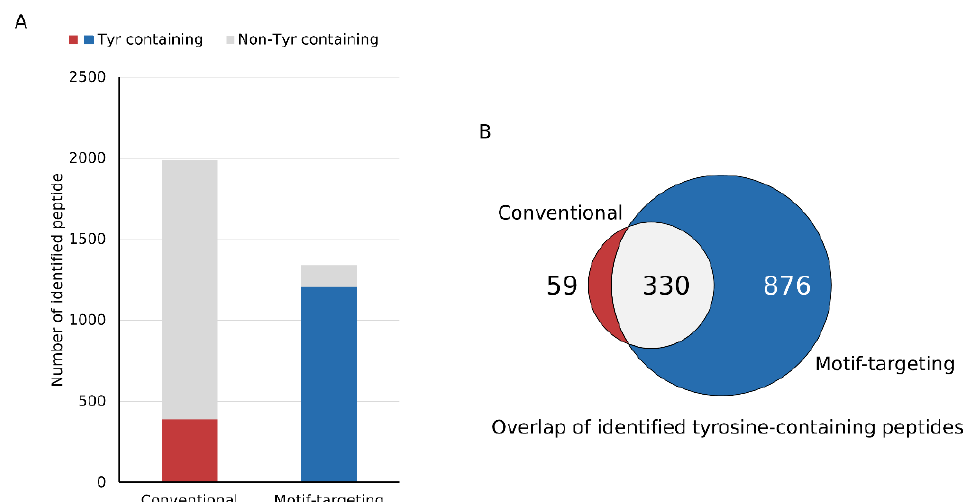
Figure 2. Identification results of tyrosine-containing peptides. ( A ) The bar chart shows the identified number of peptides in each experimental workflow. The peptides are categorized based on the presence of tyrosine residues. ( B ) The Venn diagram shows the number of tyrosine-containing peptides identified in each set. The motif-targeting workflow identified almost 85% (330 out of 389) of the peptides found in the conventional workflow.